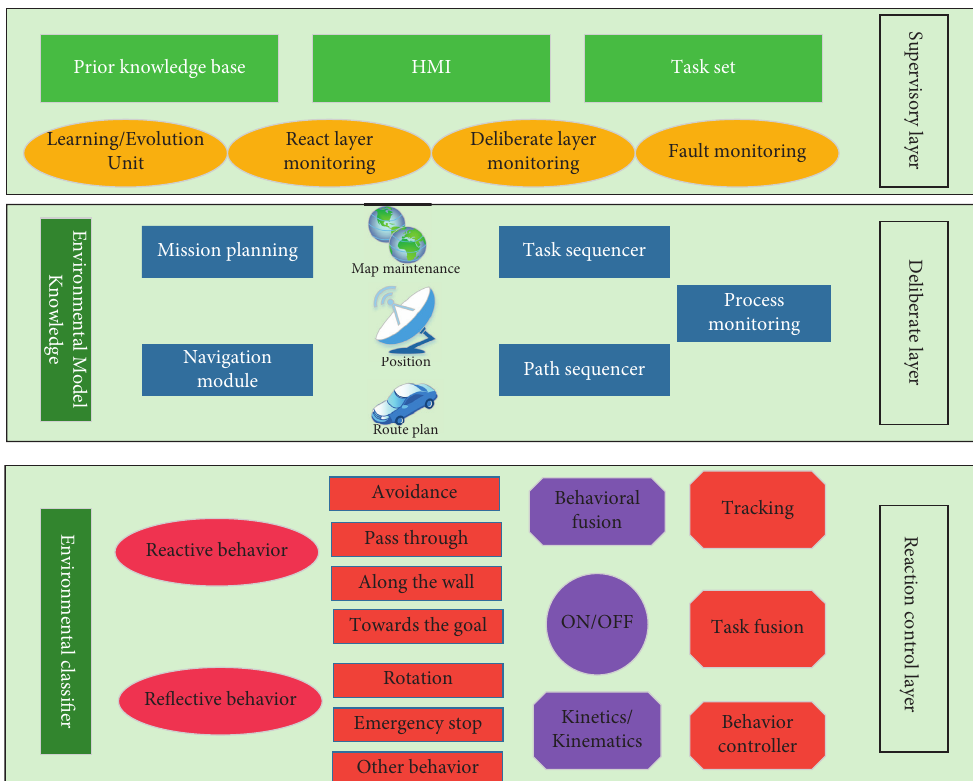
Figure 2: Mobile robot hierarchy